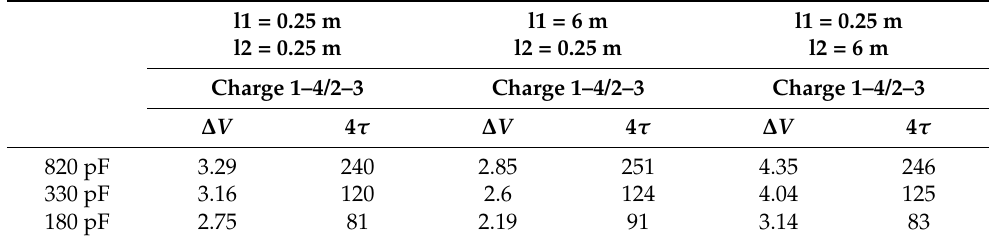
Table 3. Measurement results for the H-Bridge TX.